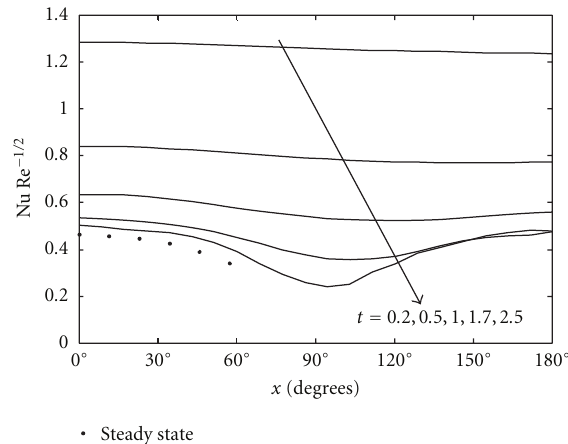
Figure 5: Variation of the Nusselt number with x for K = 2 and for various values of t when Pr = 1, α = − 1 (opposing flow) and n = 1 /